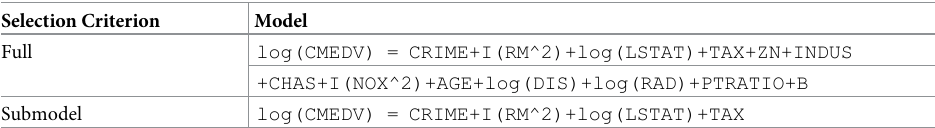
Table 1. Full and submodel for the Boston housing